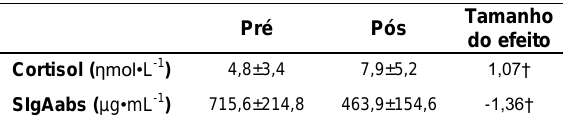
Tabela 1. Valores pré e pós-simulação (média ± desvio-padrão).